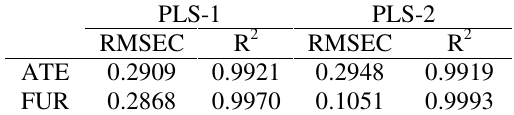
Table 4. Statistical parameters of the model optimized